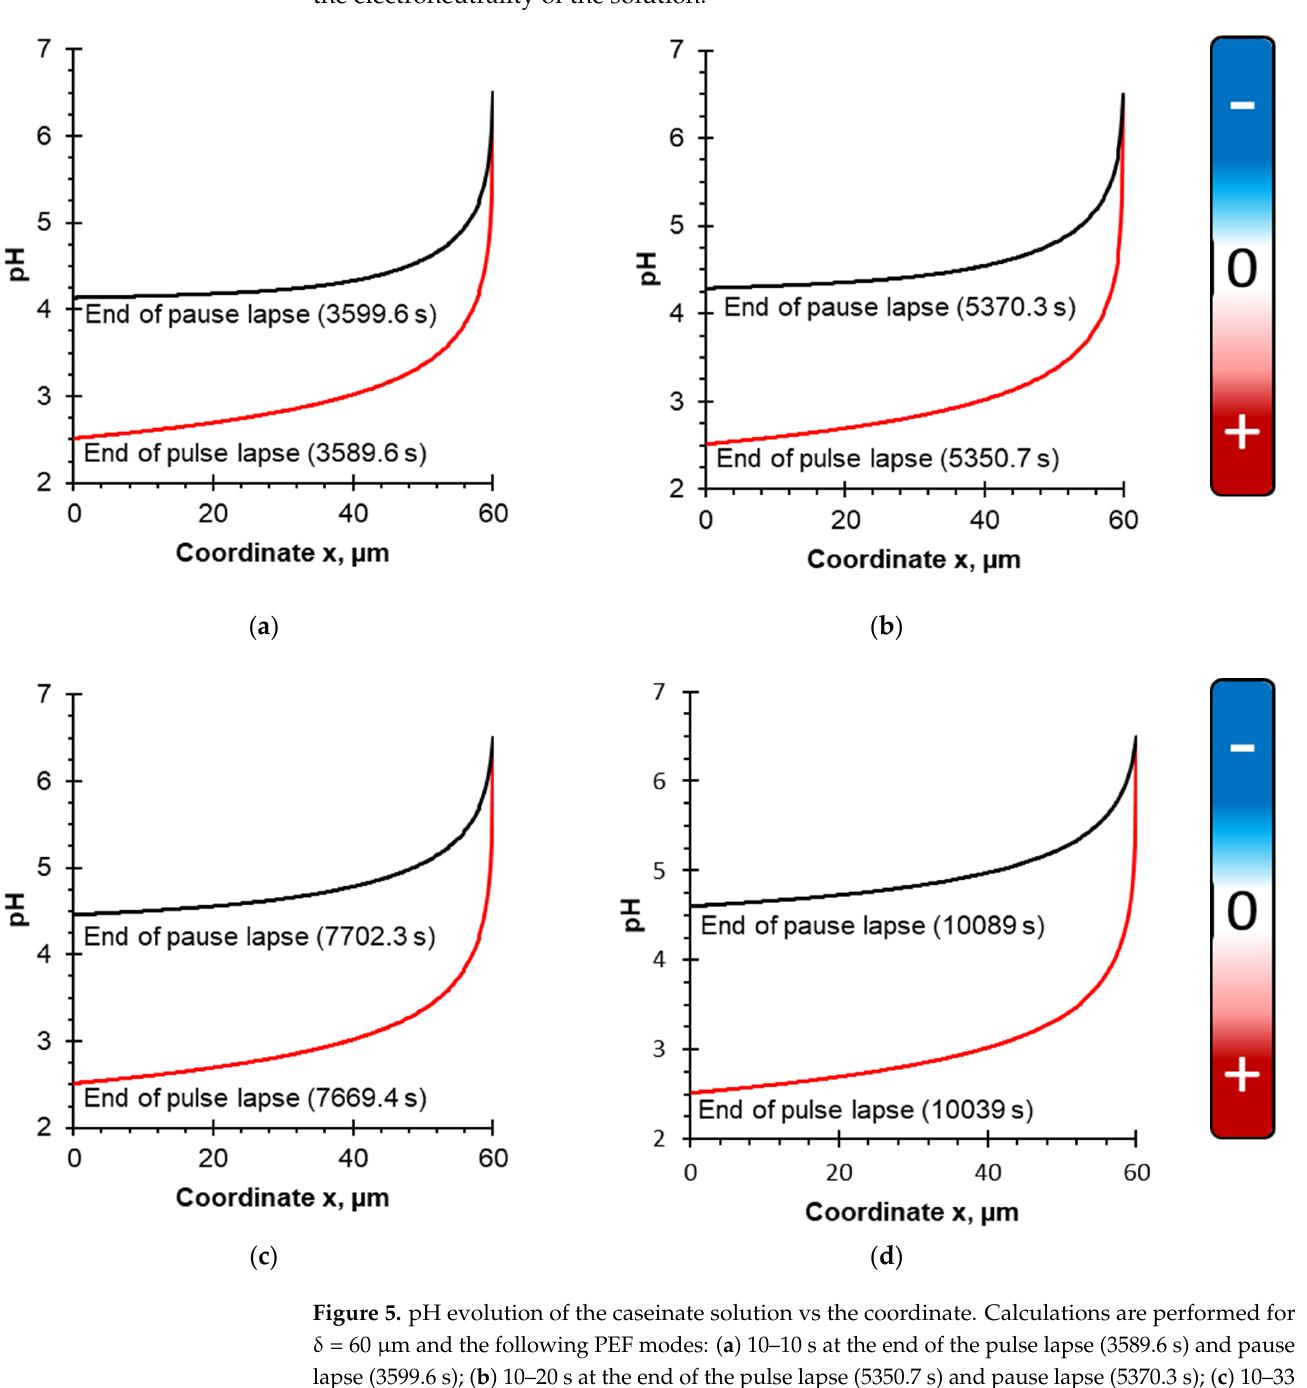
the outer boundary of the DBL, due to the short duration of the current pulse (10 s).